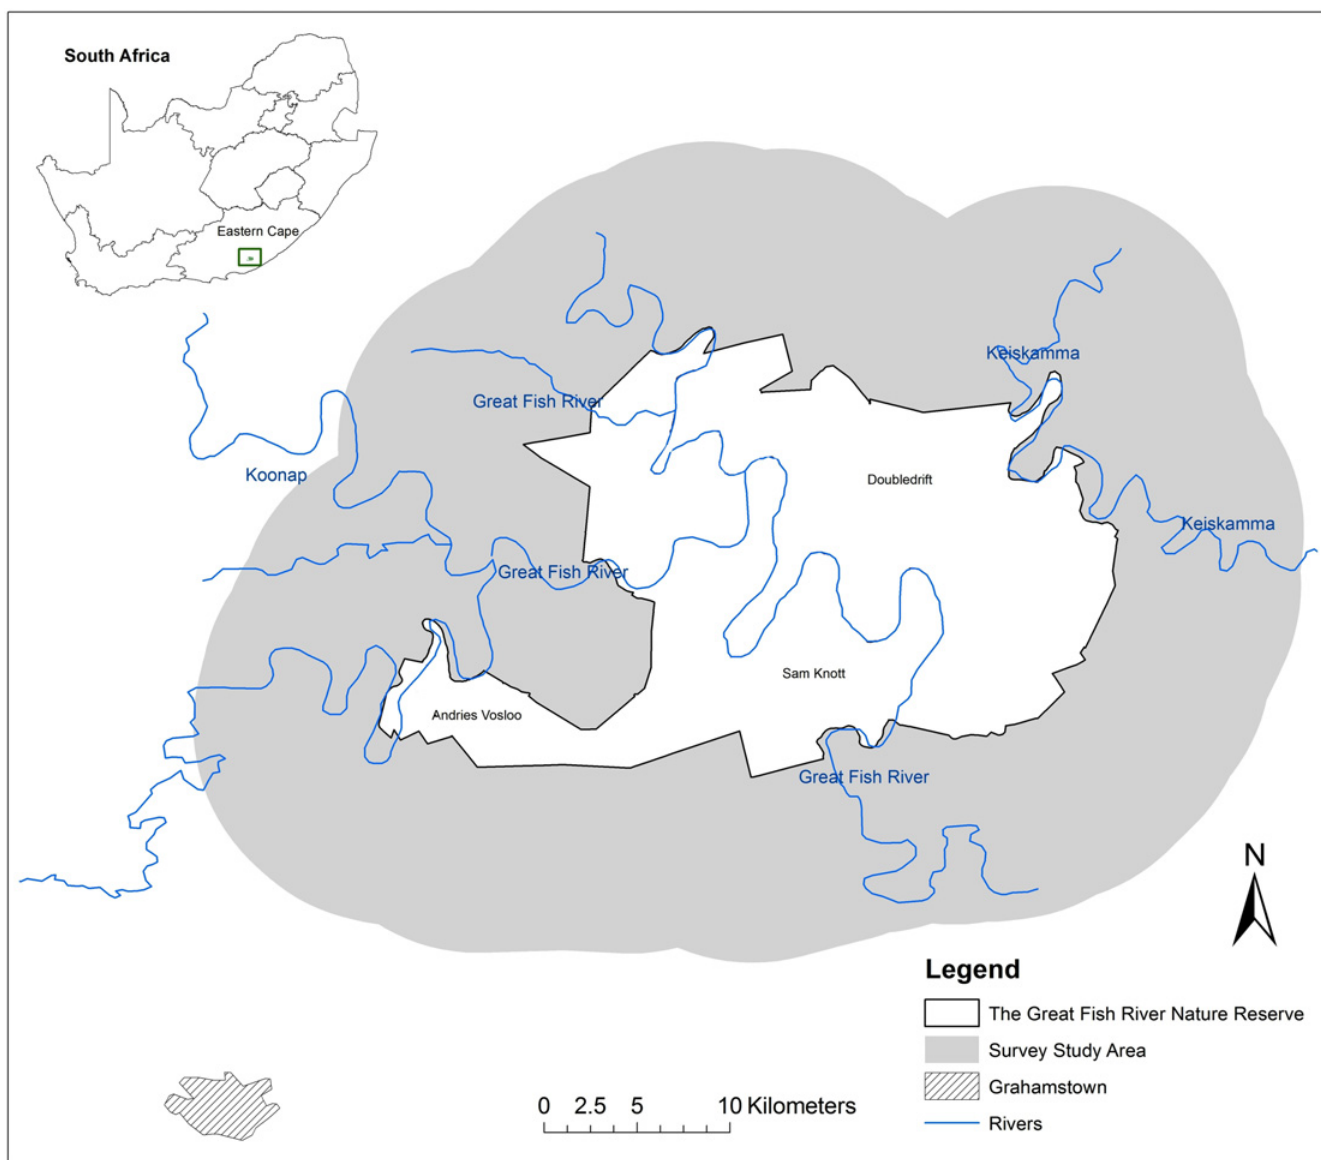
Fig 1. The Great Fish River Nature Reserve and the study area within South